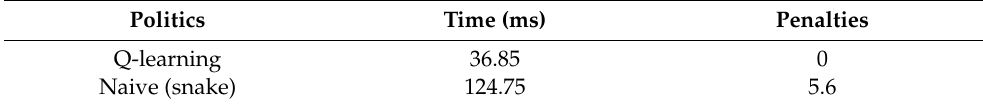
Table 5. Movement politics